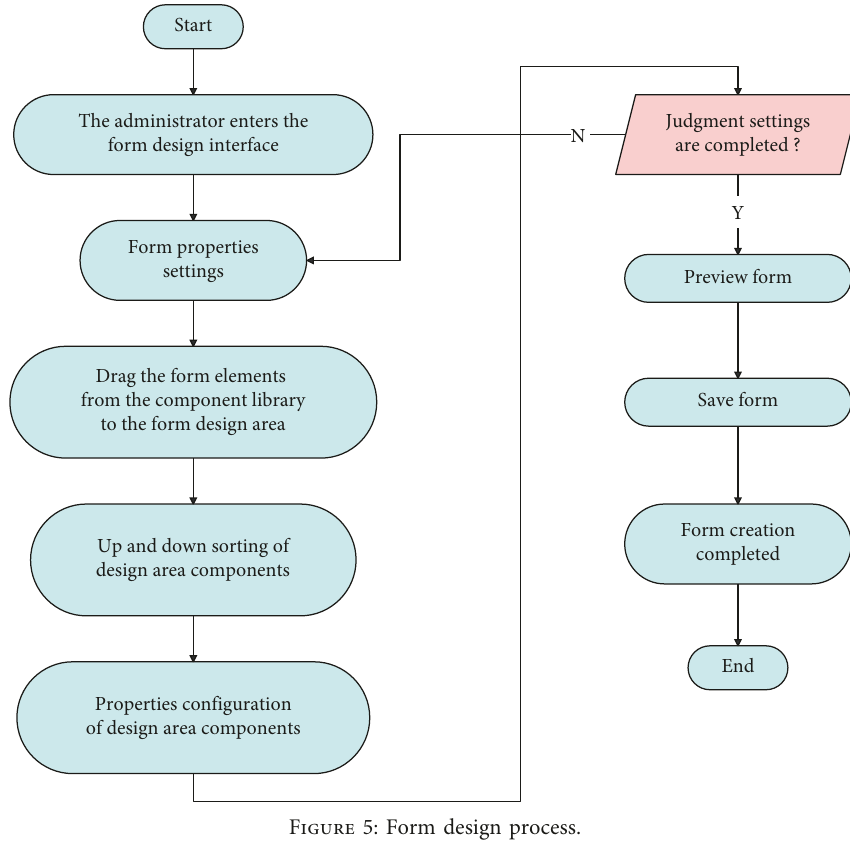
Figure 5: Form design process.